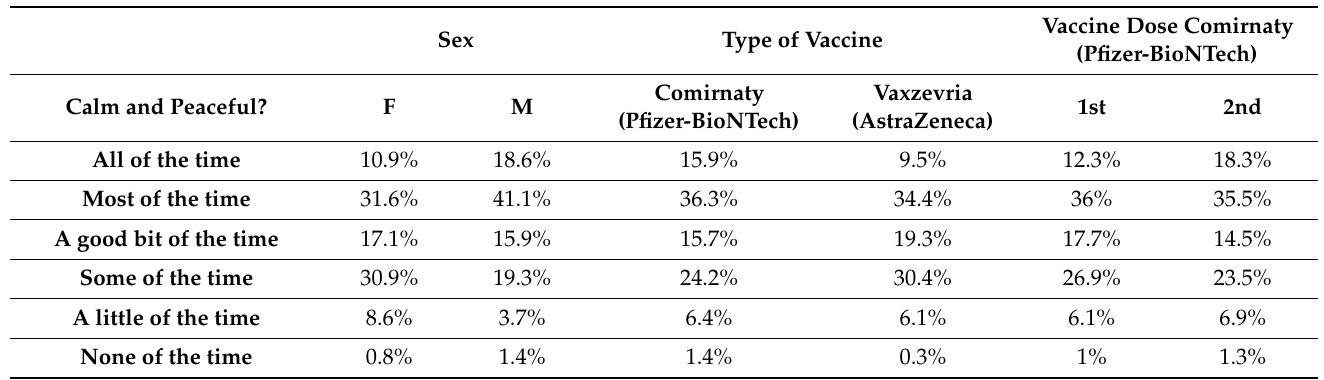
Table 2. Percentage of response frequencies related to item #9 of the SF-12 divided by variable.